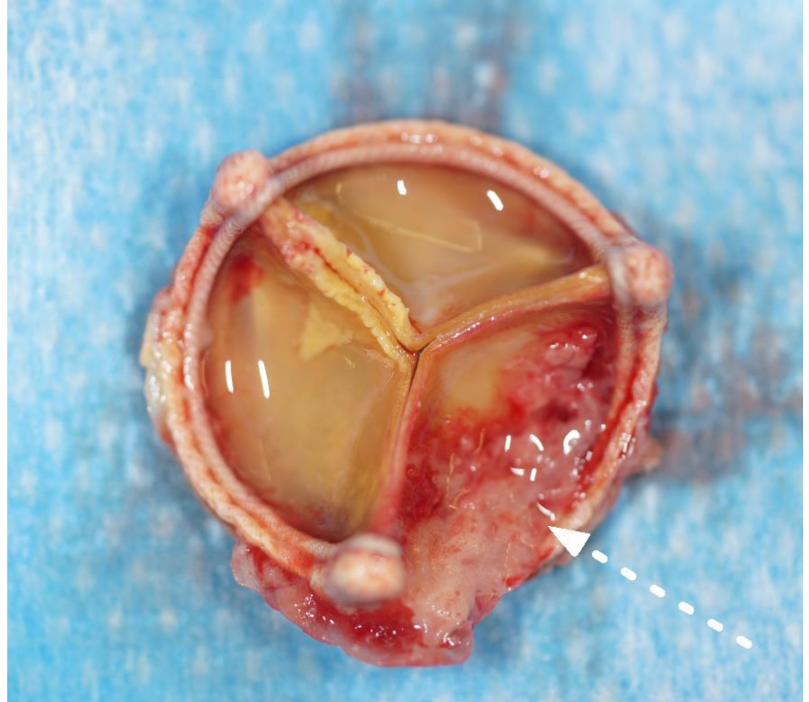
Figure 3. Explanted aortic valve bioprosthesis with fibrous, granulomatous deposits on the aortic size of the leaflets (white arrow, Case n ◦